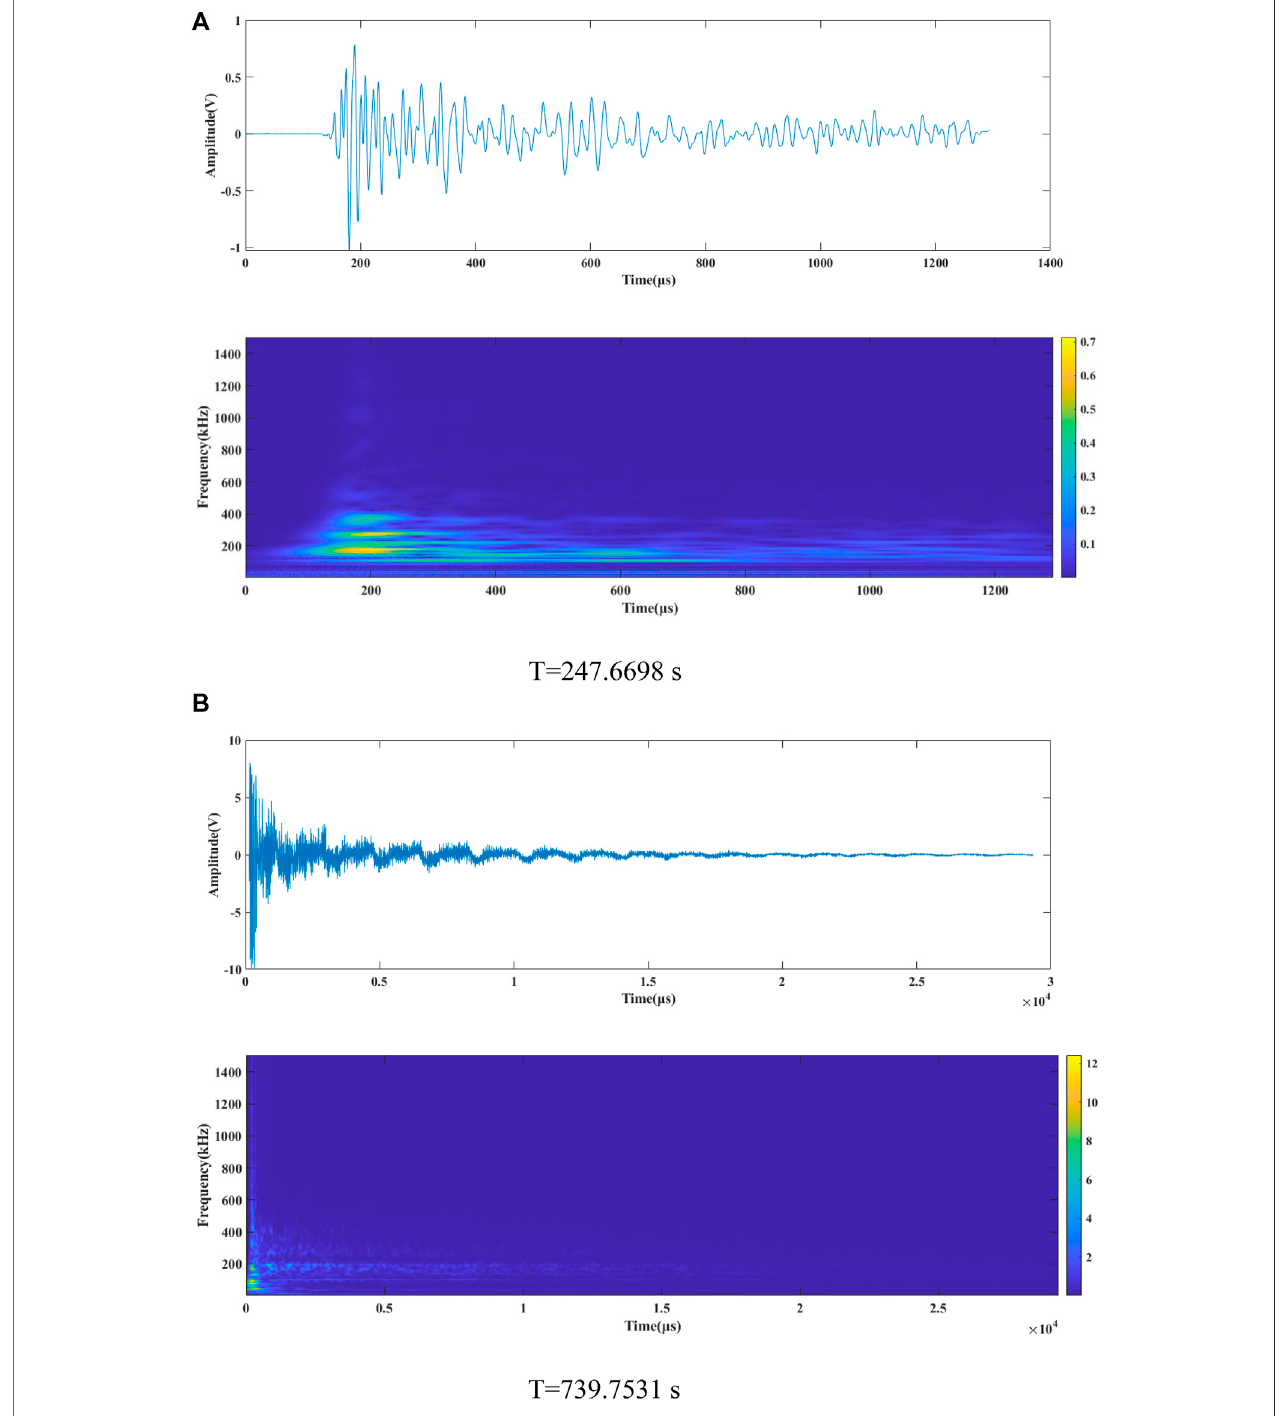
FIGURE 5 | Waveform and continuous wavelet transform diagram. (A) T = 247.6698 s; (B) T = 739.7531 s.